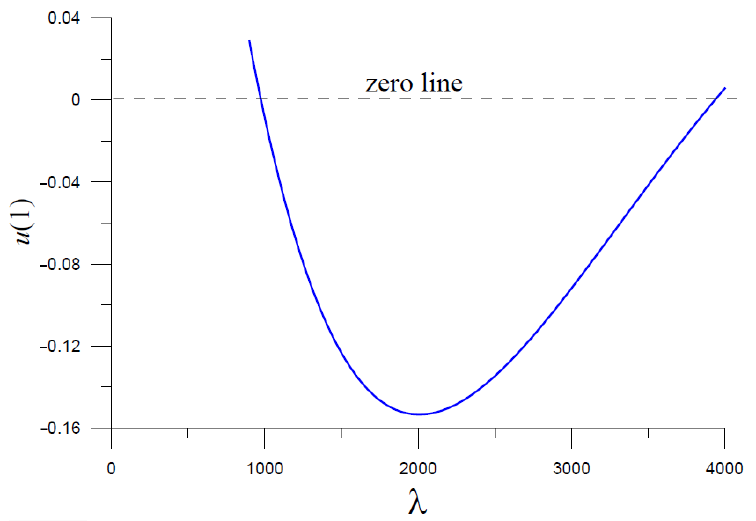
Figure 6. Plotting the eigenvalue curve for a practical example of a longitudinal wave motion of a tapered rod.